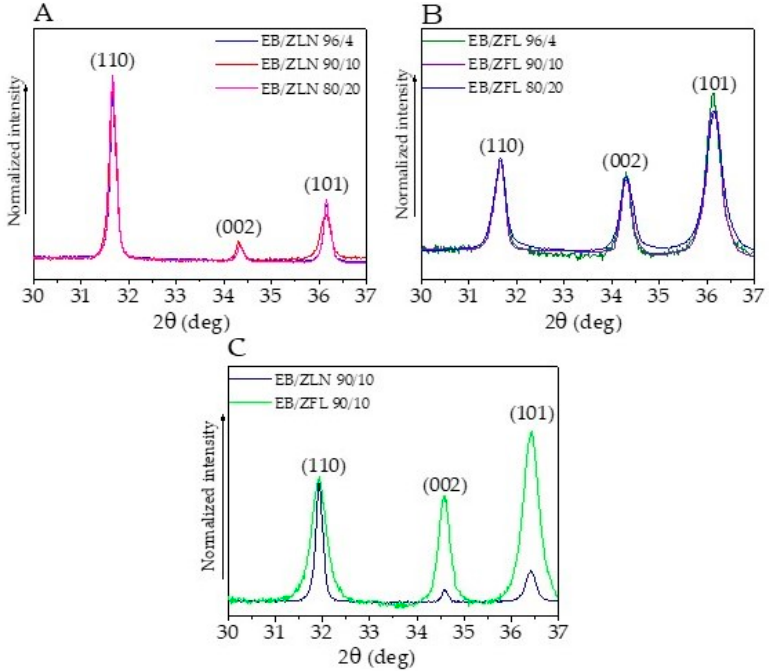
Figure 11. The typical WAXD patterns of ZnO composites in the range between 30 and 37° highlight the preferential orientation of crystallographic planes of ZFL and ZLN particles in the composite films. Spectra were normalized with respect to the (110) crystallographic peak. Spectra of EB/ZLN(A) and EB/ZFL(B) composites at different filler loadings. Comparison of EB/ZLN and EB/ZFL 90/10 spectra (C).